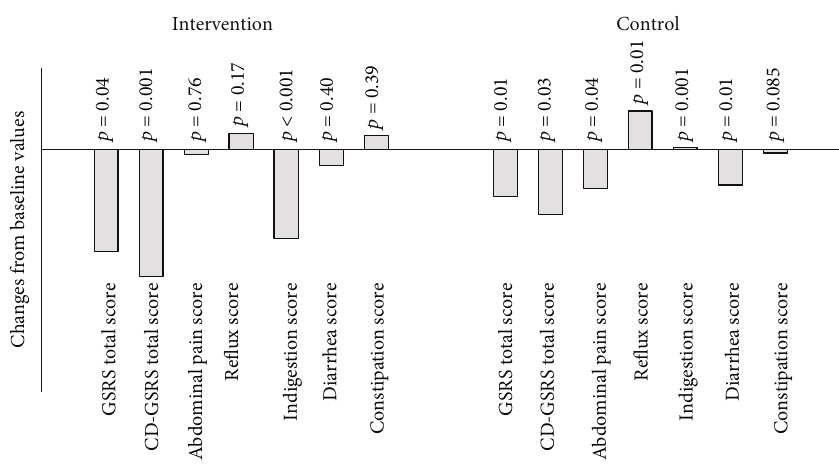
Figure 1: Mean changes from baseline of GSRS scores and subscores strati fi ed by groups. CD: celiac disease. ∗ p value of paired t- test comparing the mean changes from baseline of GSRS scores and subscores.